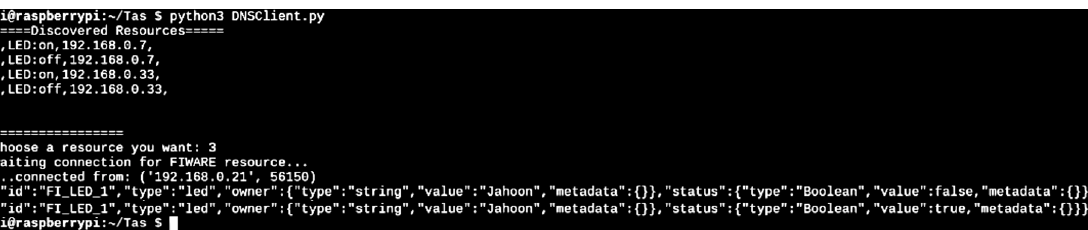
Figure 18. LED request message in IBM cloud.